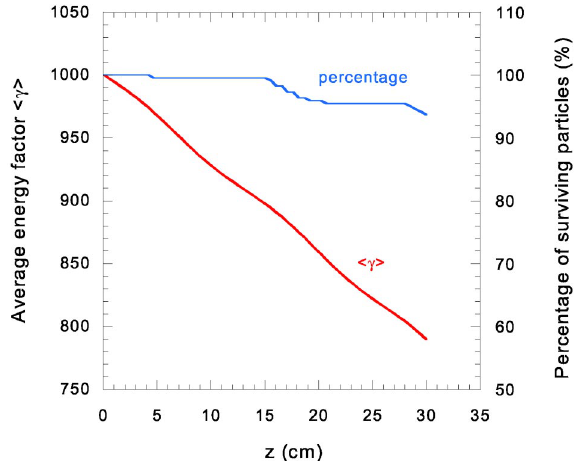
FIG. 15. (Color) Dependence of average energy factor h (cid:15) i and percentage of surviving particles on axial distance z . 93.7% of the particles survive at z (cid:3) 30 cm and they are decelerated from h (cid:15) i (cid:3) 1000 (510.5 MeV) to 789.7 (403.0 MeV), with 107.5 MeV lost to wakefields.